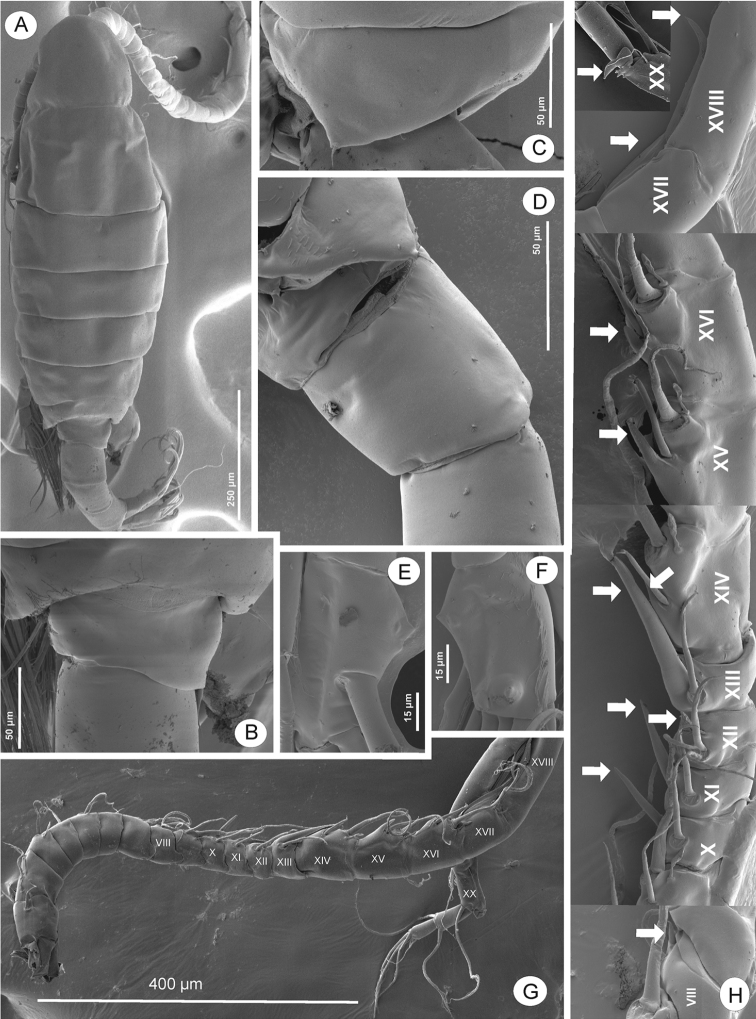
Phyllodiaptomus (P.) roietensis sp. nov., male: A habitus, dorsal view BPdg 5 and genital somite, dorsal view CPdg 5 lateral wing, left view DPdg 5, genital somite and urosomites 2 and 3, ventrolateral view E, F right caudal ramus in dorsal (E) and ventral (F) views G, H right antennule (white arrows indicate spines on segments 8, 10–18, 20.